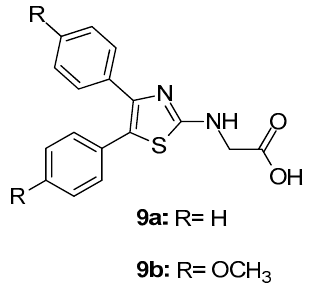
Figure 11. Chemical structures of 4,5-diarylthiazoles 9a and 9b .